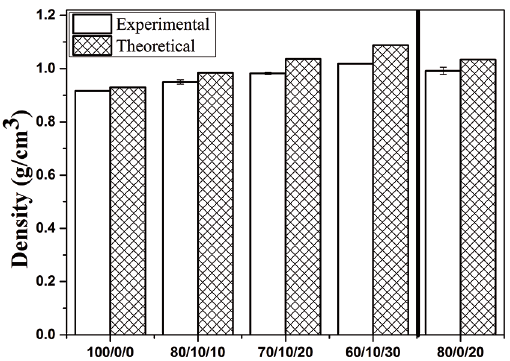
Figure 1: Theoretical and experimental density values for all formulations.